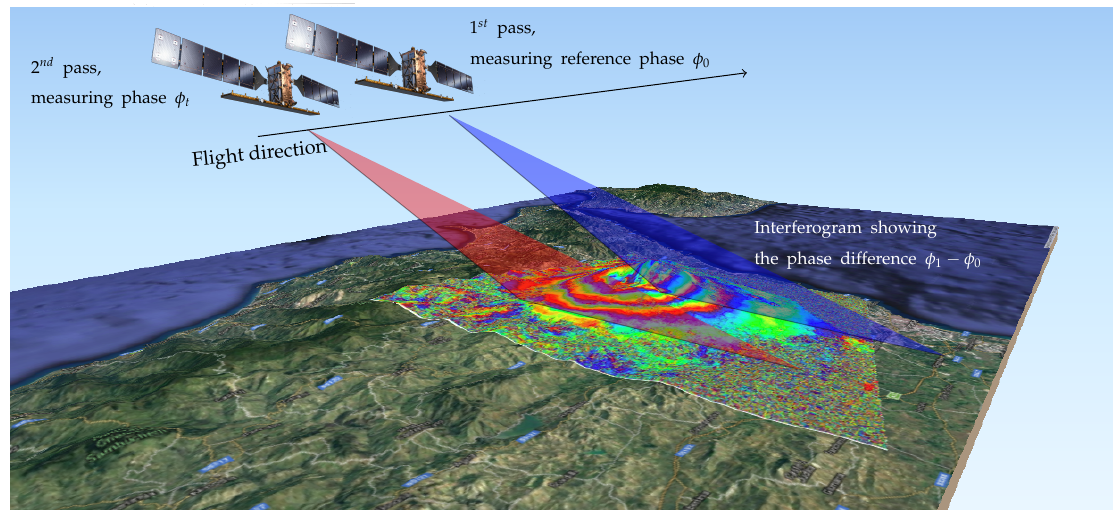
Figure 1. Pictorial representation of the DInSAR scenario; note that in this case we are assuming the ideal case of subsequent acquisitions carried out from the same orbital